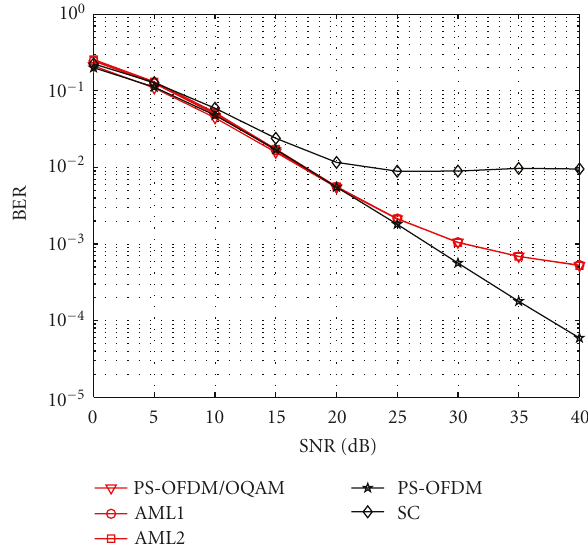
Figure 10: BER of the considered joint estimators in ITU Vehicular A multipath